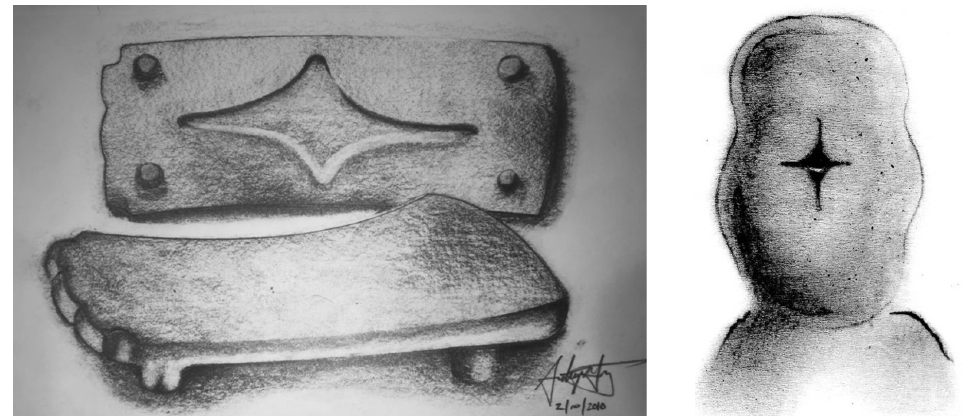
Figure 5. Left —Rendition of portable metate with the carved Venus Star on its underside. Drawing by 1st author after Guthrie (1995, p. 291). Right — Rendition of Olmec-style figurine head with the Venus Star carved on its posterior part. Drawing by 2nd author after Coe and Diehl (1980, p. 267).